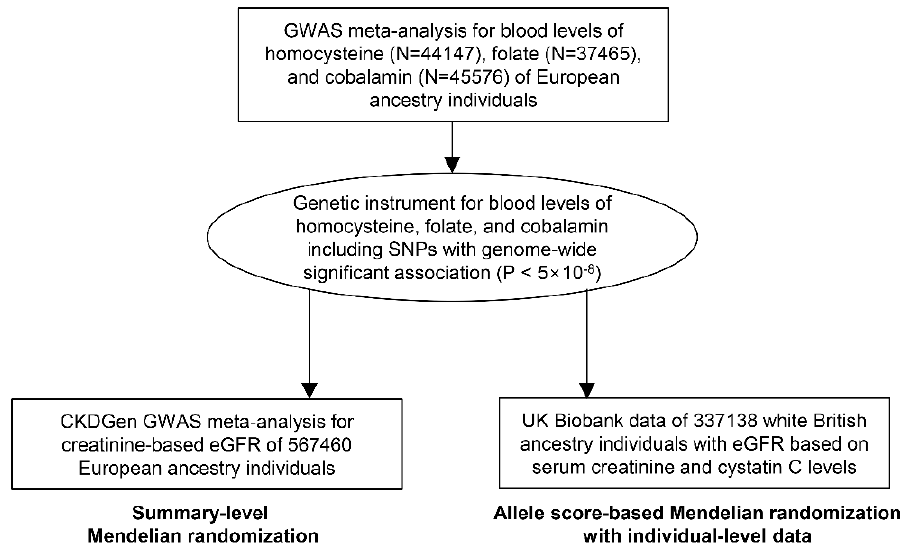
Figure 1. Study flow diagram.